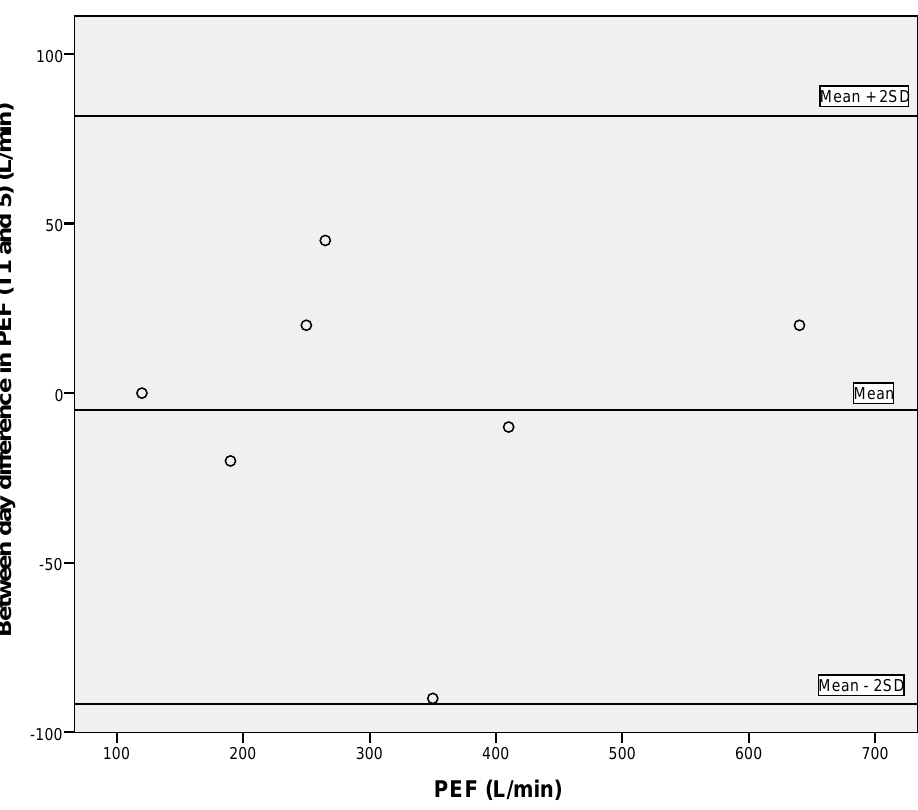
Figure 5. Bland–Altman plot showing between day variation for PEF between time point 1 and 5.